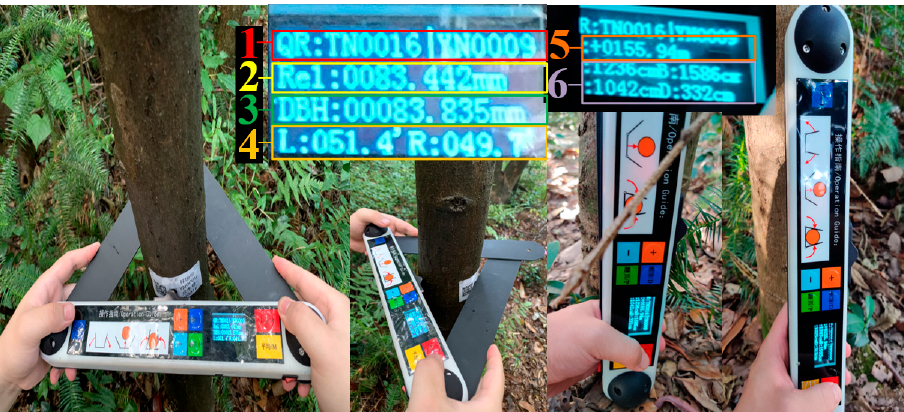
Figure 6. An example to show the anchor installation in a plot.